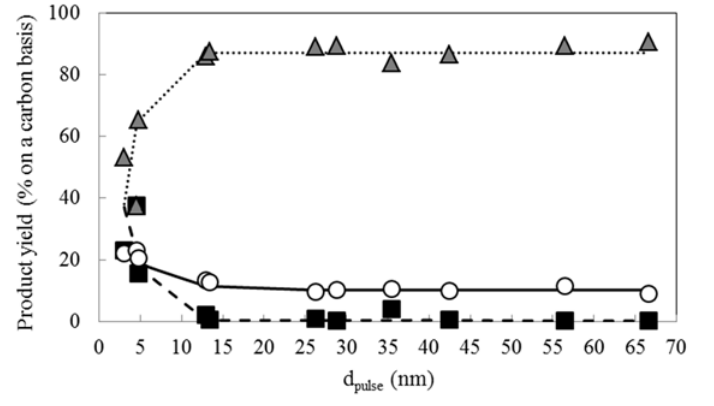
Figure 2. Effect of d pulse on product yield in the hydrocracking reaction over Pt-loaded